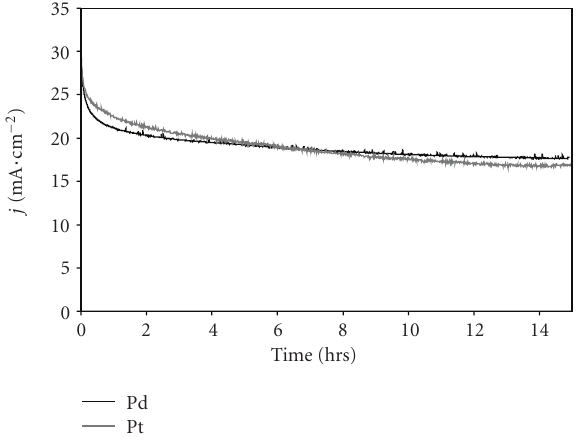
Figure 7: Chronoamperometry measurements of DMFC with Pd/C or Pt/C as cathode catalyst using the same anode materials (Pt- Ru/C) at 20 ◦ C and 5 M methanol, with oxygen.